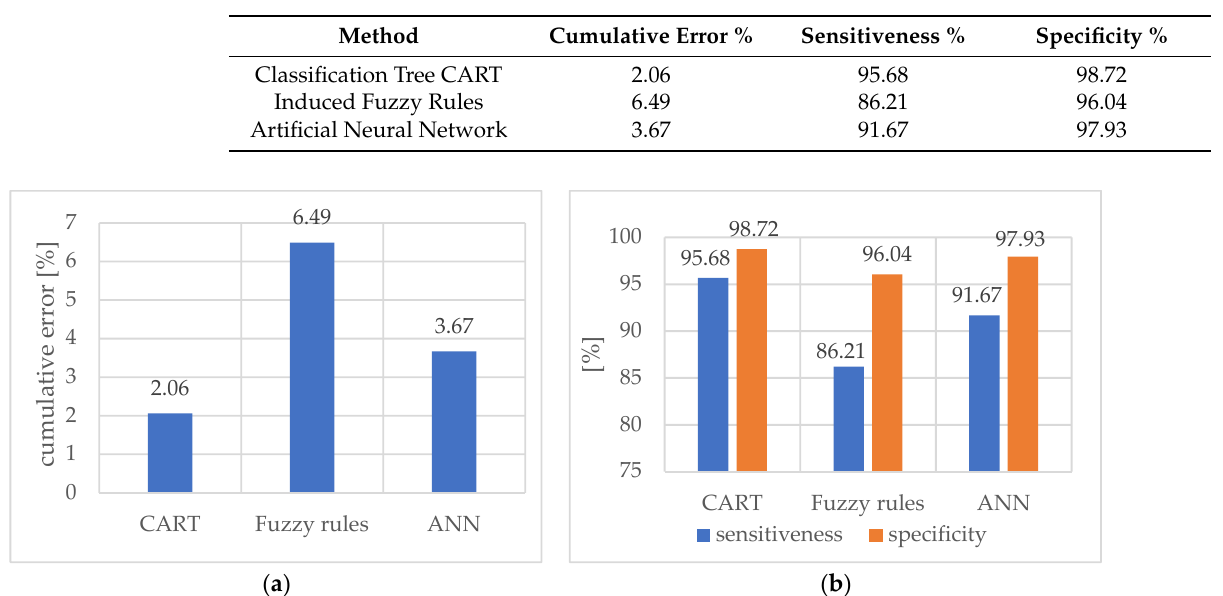
Figure 14. Comparison of cumulative error ( a ), sensitiveness, and specificity ( b ) (without the cutting parameter v c ).